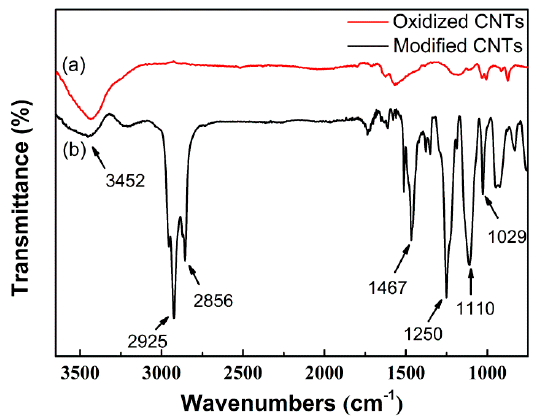
Figure 3. FTIR spectra of ( a ) oxidized CNTs and ( b ) organically modified CNTs.